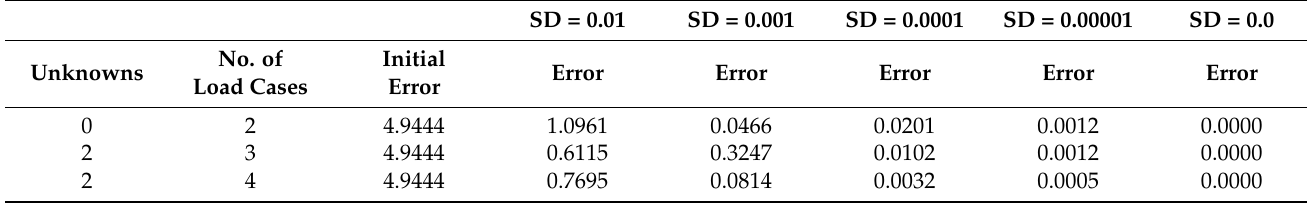
Table 8. Errors obtained for predicted temperatures for steady state 7 nodes